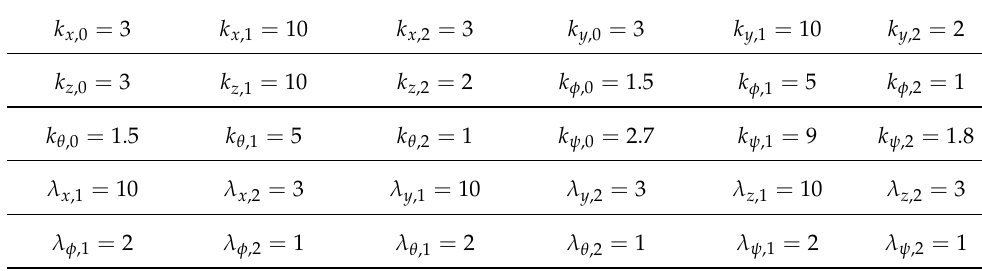
Table 3. Parameters of HOSM Controller and